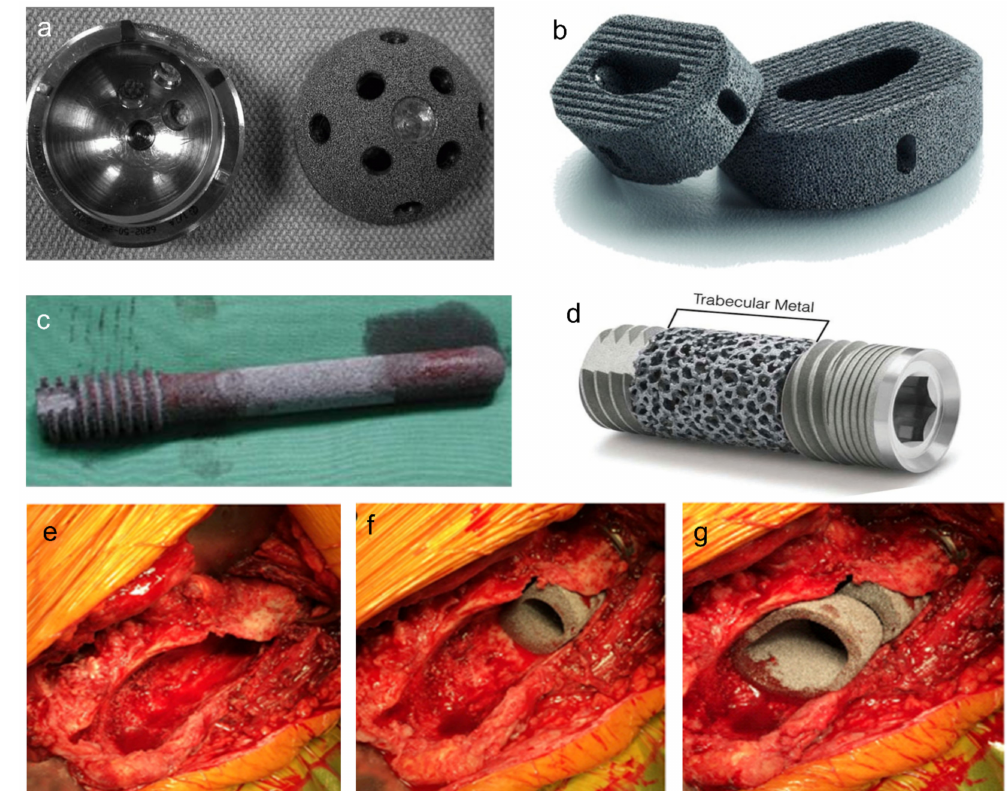
Figure 4. The typical products of porous Ta-based implants manufactured by Zimmer Biomet Inc. Acetabular cup with porous Ta coating ( a ). Reprinted with permission from [45]. Copyright © 2021 by American Academy of Orthopaedic Surgeons. Porous Ta lumbar interbody fusion cage ( b ) Reprinted from ref. [57], porous Ta rod ( c ) Reprinted from ref. [58] and dental implant ( d ) Reprinted from ref. [59]. The porous Ta cones were used to reconstruct femoral metaphyseal defect ( e – g ). Reprinted from ref.